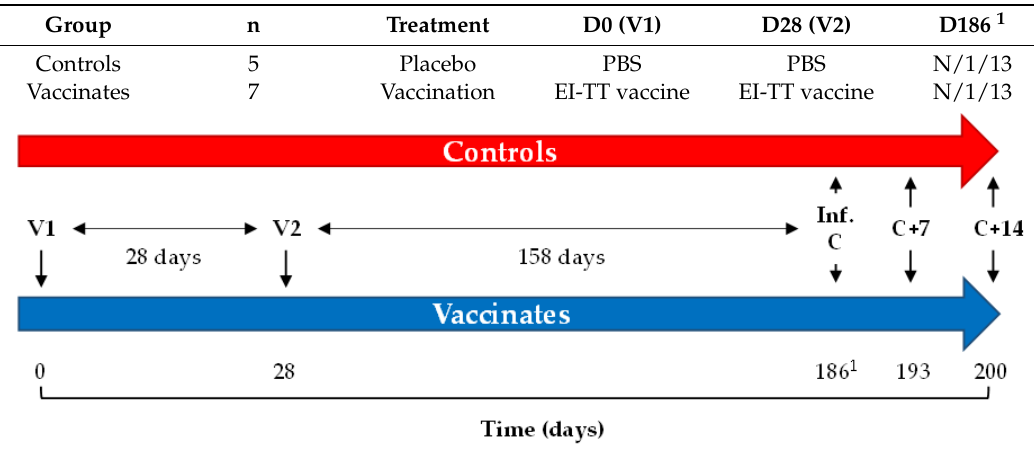
Table 1. Study design. D186 = time of experimental infection. n = number of animals; N/1/13 = A/equine/Northamptonshire/1/13; V = vaccination; Inf. C = experimental infection; C + 7 = 7 days after infection; C + 14 = 14 days after